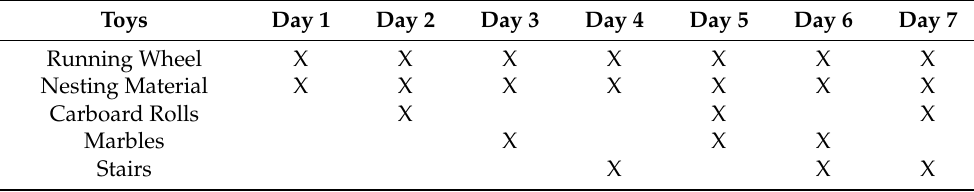
Table 2. Scheme of the toys differentially used to perform the environmental enrichment for the 7-week-old CD1 male mice. An X in a square states that the toy (raw) was present in the cage for that specific day (column). If a cell is empty, it means that the toy (row) was not present for that specific day